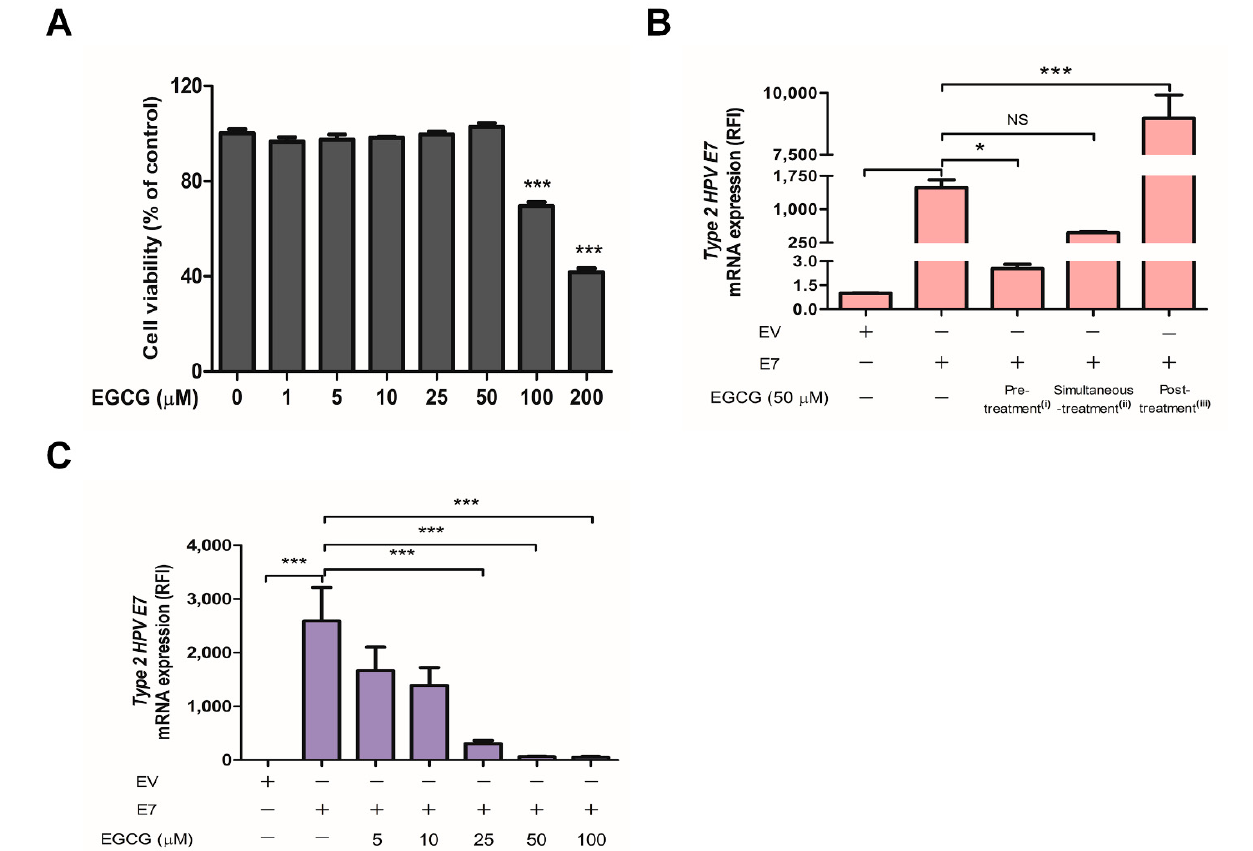
Figure 4. Effect of EGCG treatment against HPV-2 E7 transfection. ( A ) EGCG toxicity in HaCaT cells. Cells were cultured in serum-free DMEM for 24 h, and then treated with EGCG at the indicated concentrations for 24 h. Cell viability was measured using MTT assay and expressed as a percentage of the value for untreated cells. The results are the mean ± SEM for three independent experiments. *** p < 0.001 compared with untreated cells. ( B ) HaCaT cells were incubated (i) with 50 µ M EGCG for 2 h before HPV-2 E7 transfection, then removed and performed transfection (Pre-treatment), (ii) with 50 µ M EGCG for 24 h during transfection, then the EGCG and HPV-2 E7 were removed (Simultaneous-treatment), or (iii) with 50 µ M EGCG for 24 h after HPV-2 E7 transfection and removal, then the EGCG was removed (Post-treatment). RNA was extracted from cells of the three groups and HPV-2 E7 mRNA levels measured and expressed as a relative fold increase on the EGCG untreated controls. ( C ) HaCaT cells were treated with the indicated concentrations of EGCG for 2 h prior to E7 transfection. After transfection, total RNA extracted from cells was subjected to RT-qPCR for mRNA levels of HPV-2 E7 . The relative mRNA levels were normalized against levels of GAPDH . The results are the mean ± SEM for three independent experiments. * p < 0.05, *** p < 0.001 compared with empty vector or E7 . NS,